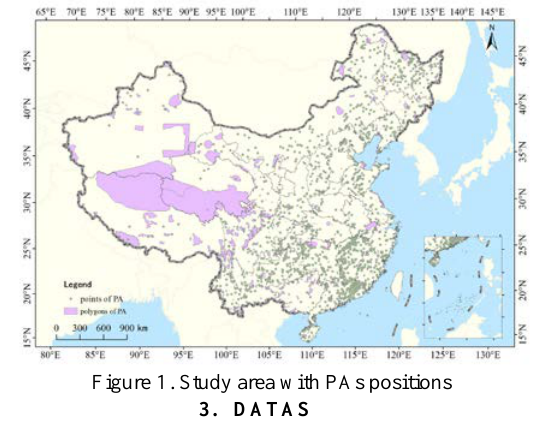
Figure 1. Study area with PAs positions